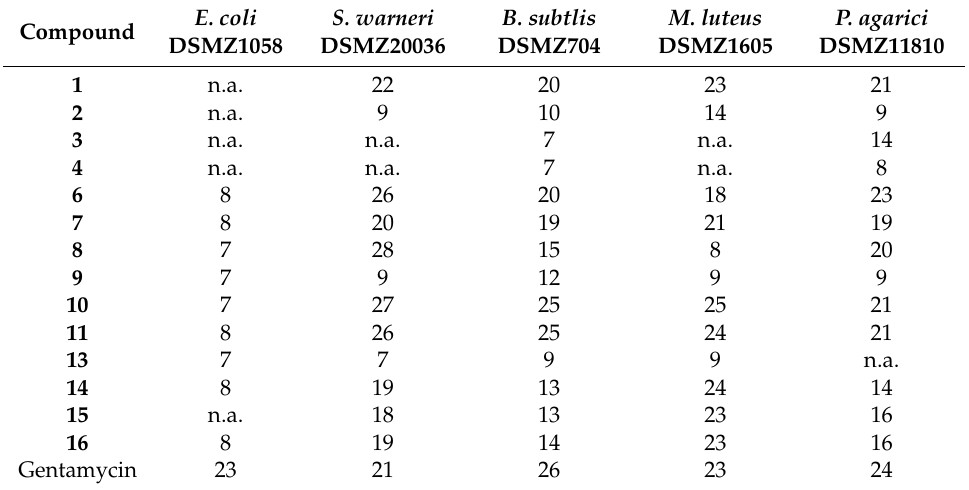
Gentamycin 24 n.a.: not active; all values are mean values ± standard deviation of three